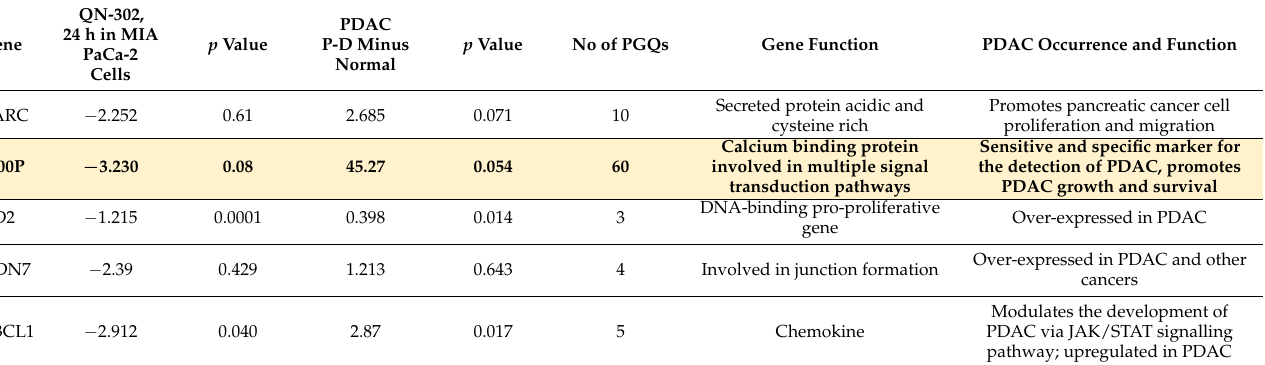
Table 1. Expression changes in selected genes previously identified as human PDAC-associated and responsive in QN-302 cell studies. Gene data taken from list of 229 genes with mutations and/or altered expression in PDAC, detailed in the Cancer Genetics Web site: http://www.cancerindex.org/ geneweb/X0603.htm, accessed on 17 November 2022. mRNA data were taken from UCL RNA-seq transcriptome data on MIA PaCa-2 cells dosed with QN-302 [21]. PSQs are the number of putative quadruplexes found in a gene